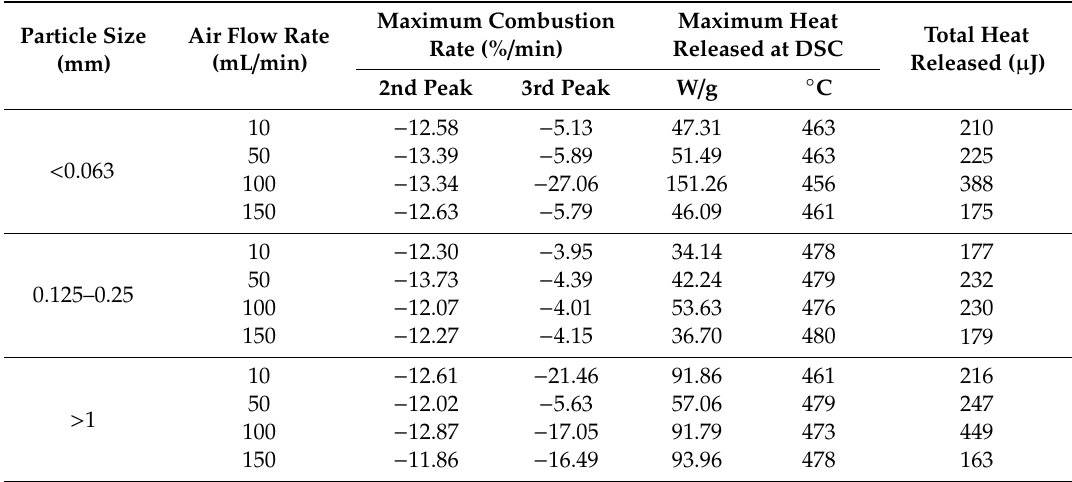
Table 5. Characteristic parameters obtained from the DTG and heat flow